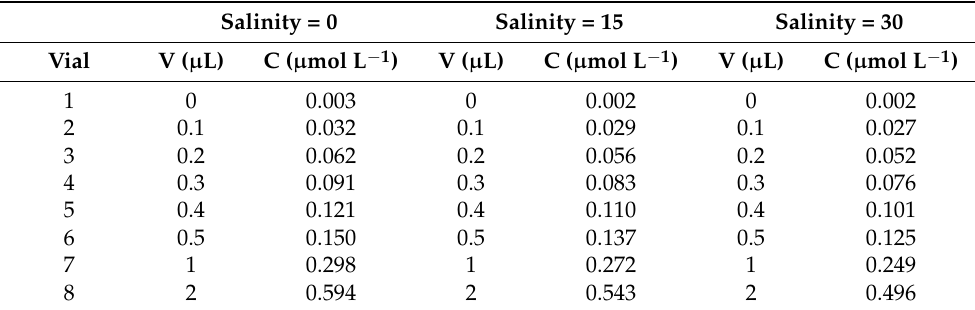
Table 2. Concentrations of CH 4 in standard samples (T = 20 ◦